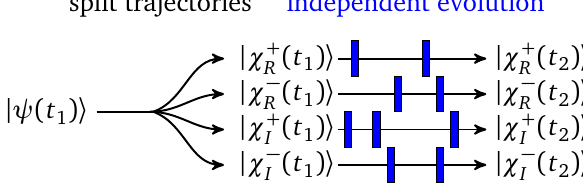
Figure 8: Sketch of the creation of one sample for the computation of two-time corre- lators following Ref. [ 3 ] . The initial dynamics up to time t of the wave function into four trajectories from which the two-time expectation value at t can be reconstructed. Then each sub-trajectory is evolved 1